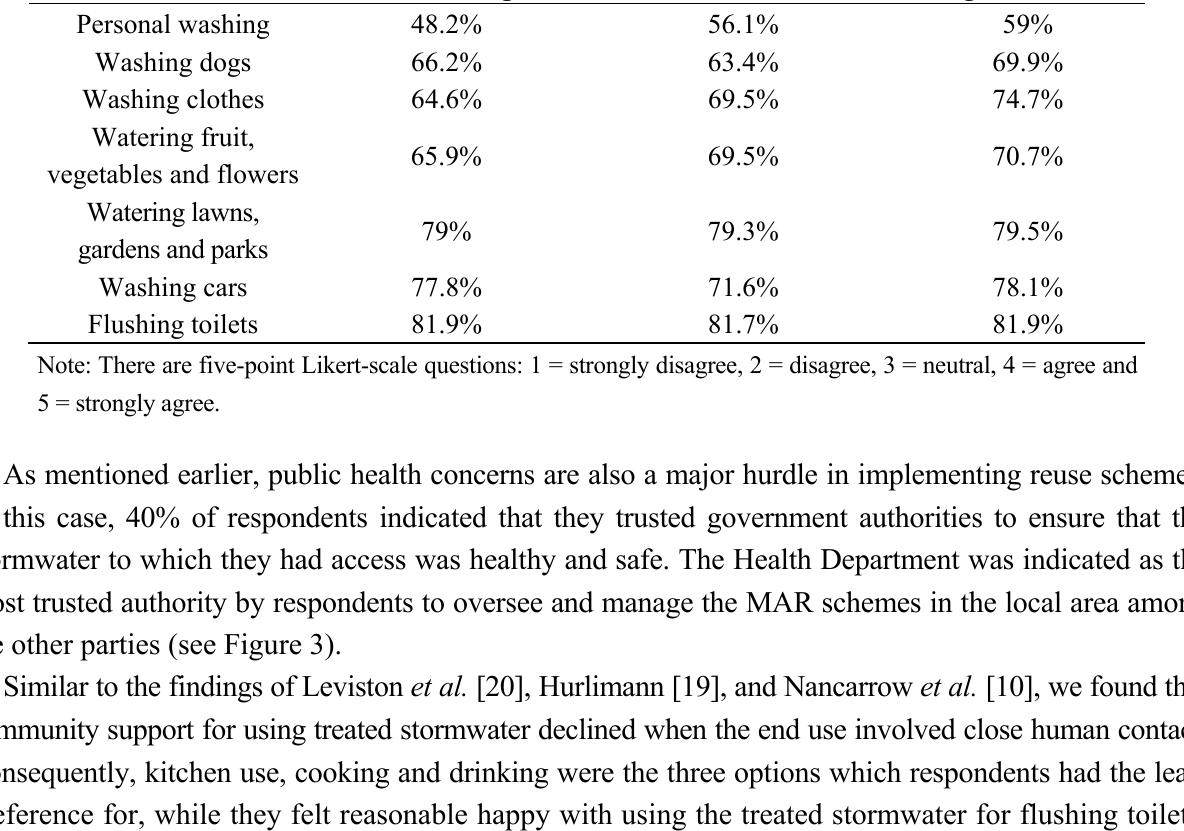
Table 1. Community perception of whether using the treated stormwater for non-potable uses is good for managing water shortages, good for the environment, and/or good for next generations. Good for the next Good for managing Good for the environment Non-potable uses generations water shortages Personal washing 48.2% 56.1% 59% Washing dogs 66.2% 63.4% 69.9% Washing clothes 64.6% 69.5% 74.7% Watering fruit, 65.9% vegetables and flowers Watering lawns, gardens and parks Washing cars Flushing